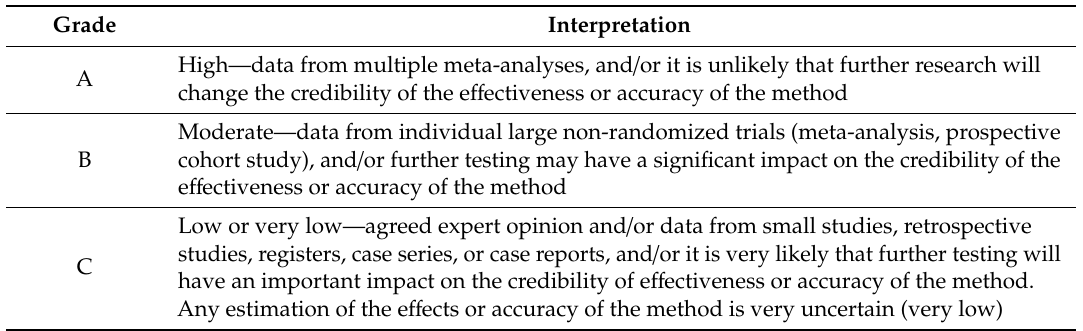
Table 2. Quality of evidence, GRADE.